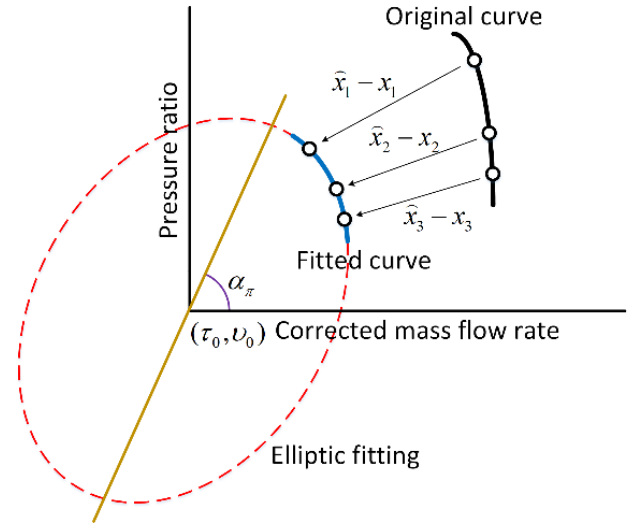
Figure 5. Application of this elliptic fitting method.